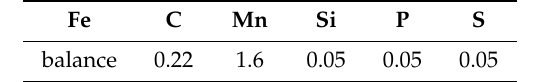
Table 1. Chemical composition of S235 steel in wt.%.